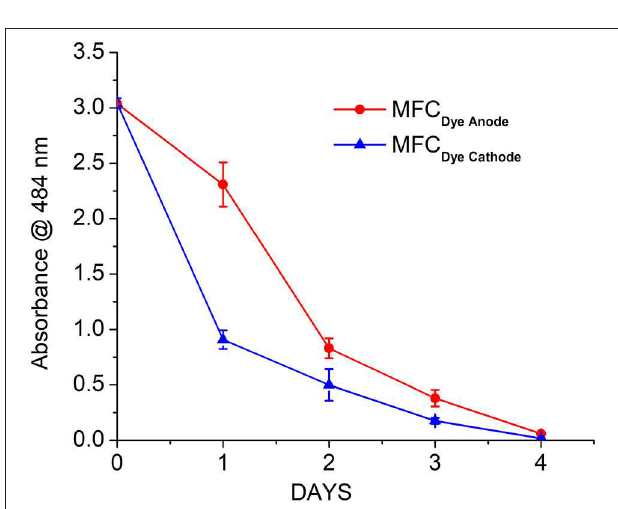
FIGURE 3 | Decolourization of AO7 in the anode ( Shewanella oneidensis ) and cathode (Laccase) of MFC over a period of 4